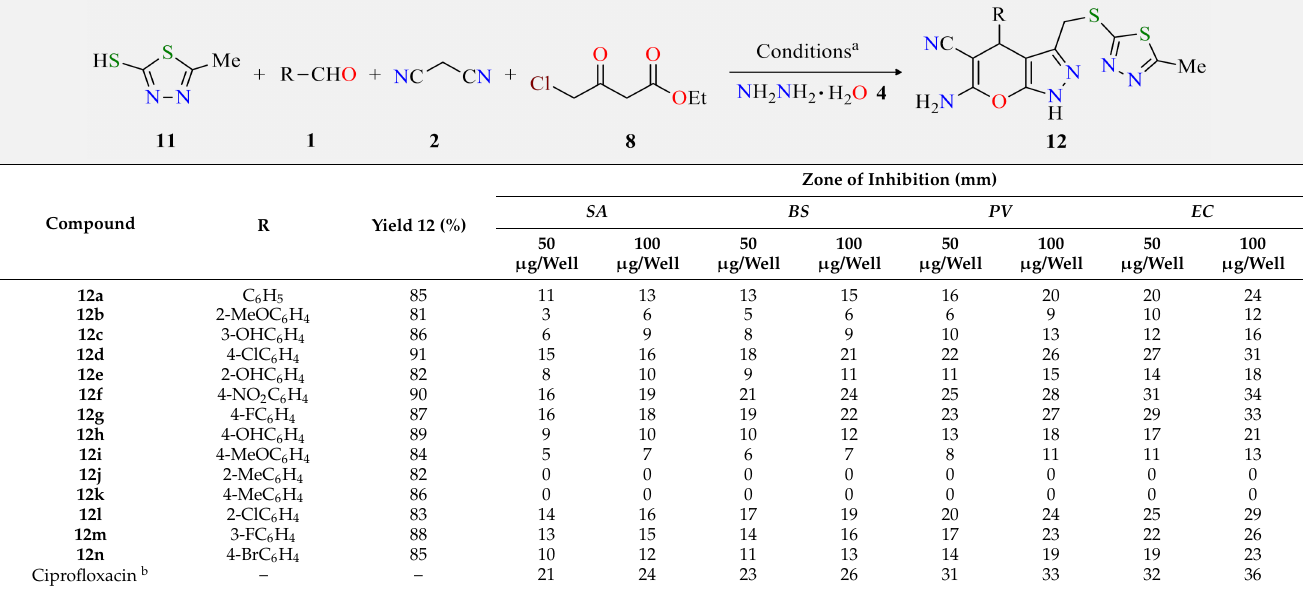
Table 2. Solvent-free five-component synthesis of pyrano[2,3- c ]pyrazoles 12 as antimicrobial